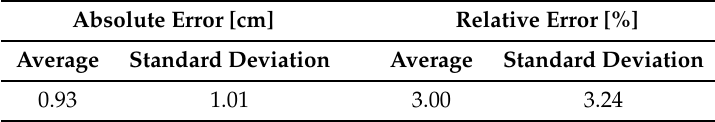
Table 3. Experimental result of belt insertion distance estimation.